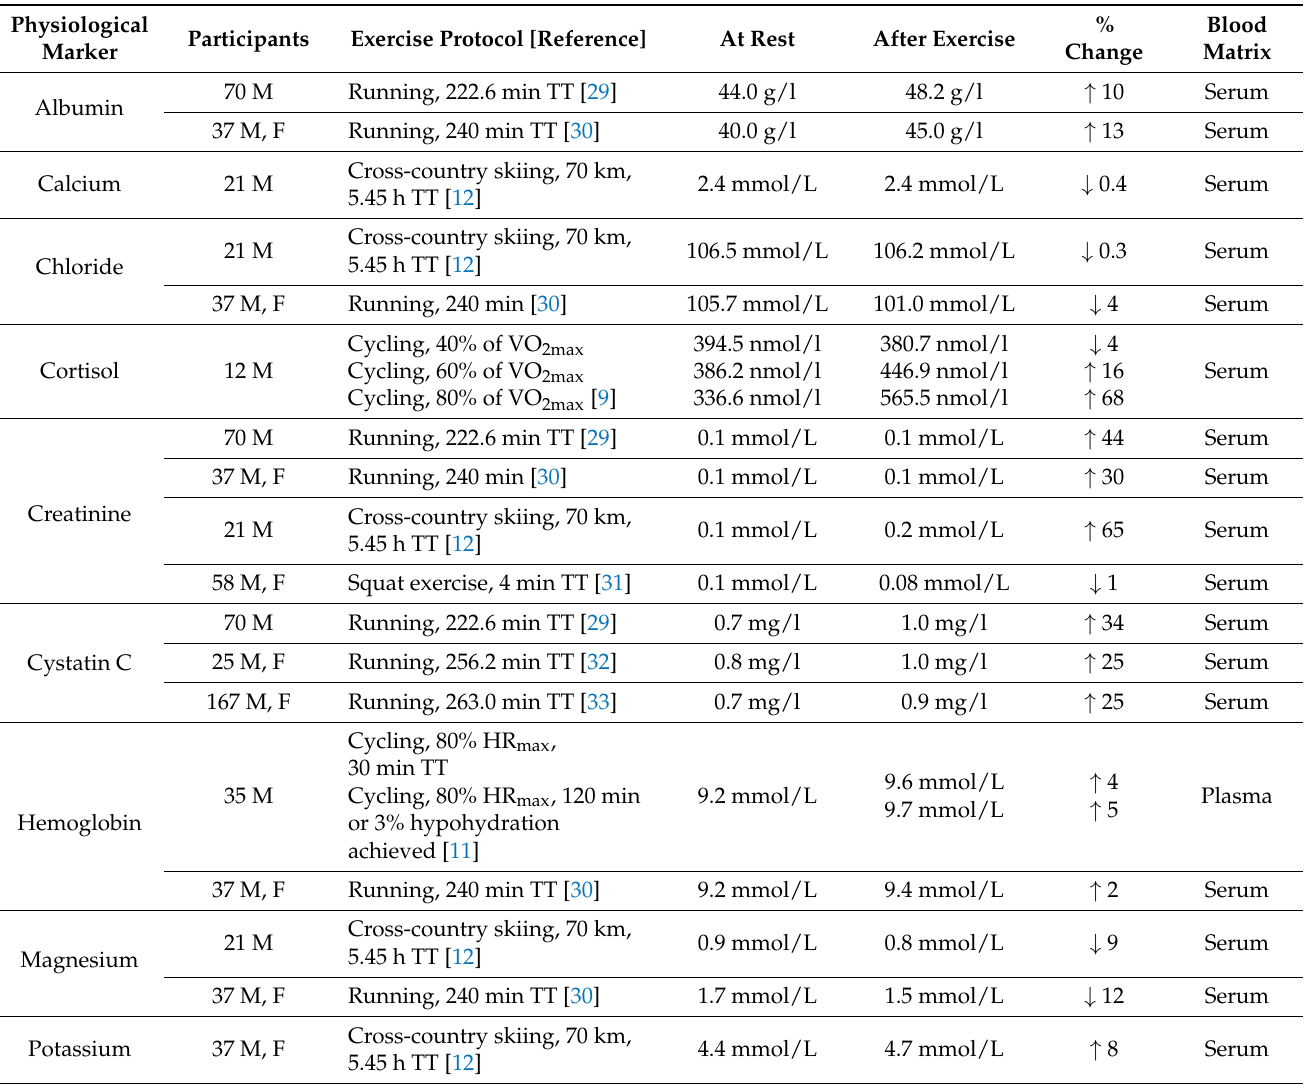
Table 1. Comparison of different blood physiological markers in serum or plasma at rest and after